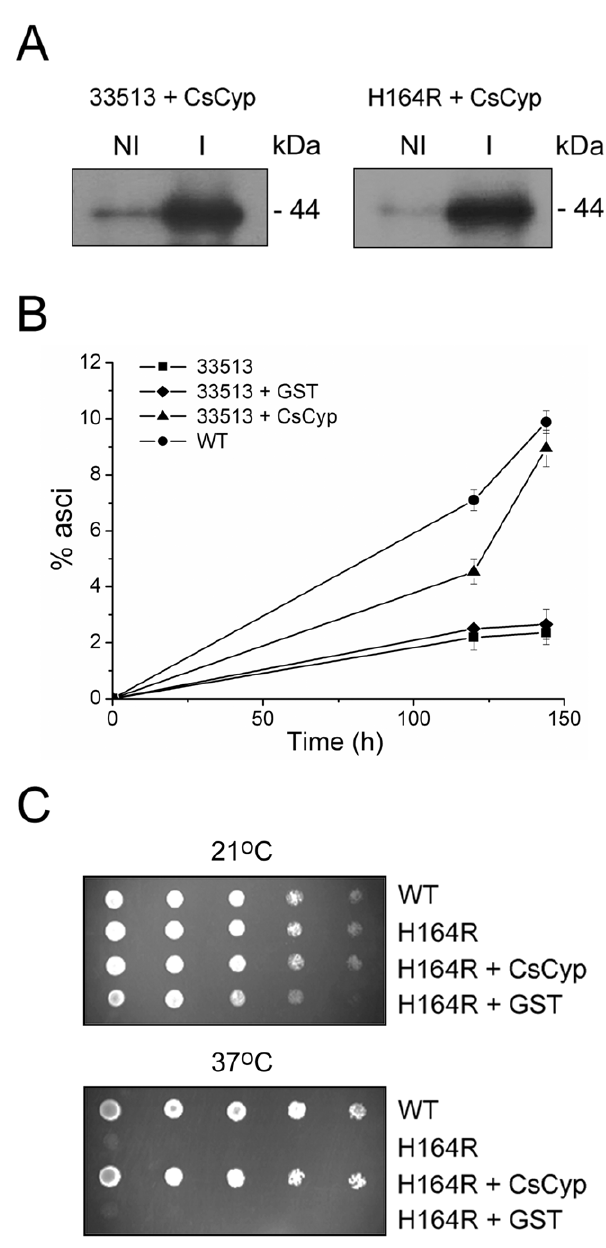
Figure 1. CsCyp complements the cpr1 D /cpr1 D and ess1 H164R yeast mutants. (A) Expression of CsCyp as a GST fusion in the yeast cpr1 D /cpr1 D (33513) and ess1 H164R mutants, under the control of a copper-induced promoter. The recombinant proteins were induced with 0.5 mM copper sulfate for 2 h and probed with the anti-GST serum. Induced (I) and non-induced (NI) samples are shown. (B) The cpr1 D /cpr1 D mutant expressing GST-CsCyp ( m ) but not GST alone ( ¤ ) increased the rates of sporulation of the 33513 mutant, relative to non- N transformed cells ( & ). Wild type cells used as reference are indicated ). Sporulation was measured at different time points after transfer of ( the cells to sporulation medium and plotted as the percentage of asci formed. Measurements are the means of ten independent countings and the error bars represent standard deviations. (C) Growth of W303- 1A wild-type (WT) and ess1 H164R mutant (H164R) in YPD medium supplemented with 0.1 mM copper sulfate at the permissive (21 u C) and non-permissive (37 u C) temperatures. Cells were grown to the mid-log phase and serial dilutions were spotted onto plates and incubated for 24 h at the indicated temperatures. The growth of the ess1 H164R mutant at 37 u C was rescued by GST-CsCyp but not GST alone. Non-transformed